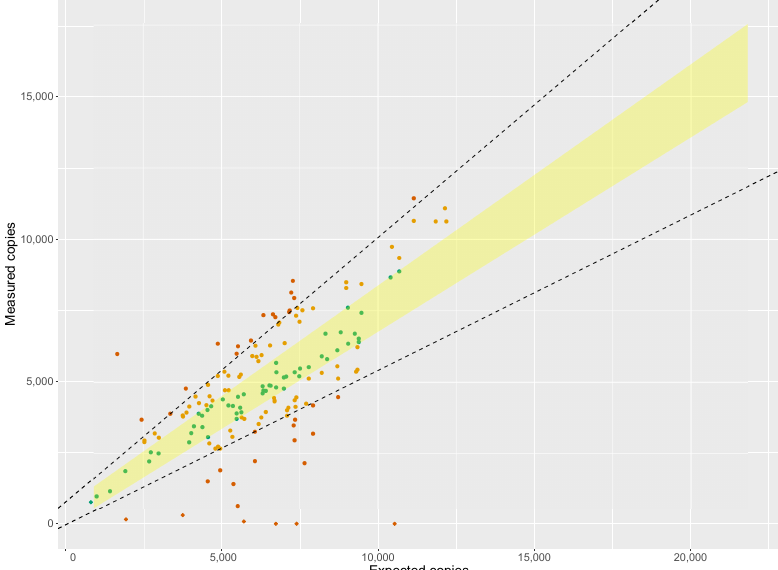
Figure 2. Overview of the market sample results: measured copies per sample plotted in function of their ’expected copies’, the shaded area represents the 95% prediction area based on the regression of the reference samples. The boundaries of the acceptable range (80% and 120% ddPCR purity) are shown as dashed lines. Samples have been colored depending on their categorization: green for